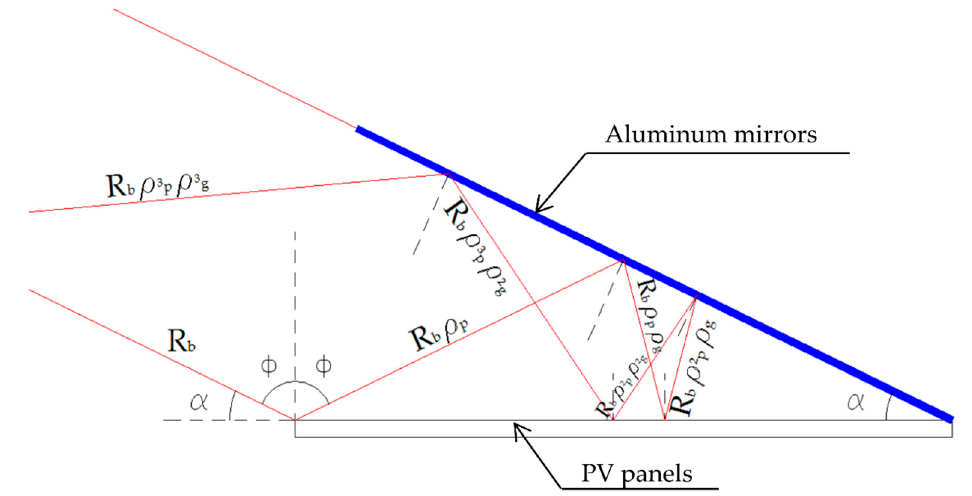
Figure 3. Functioning of aluminum reflective mirrors.